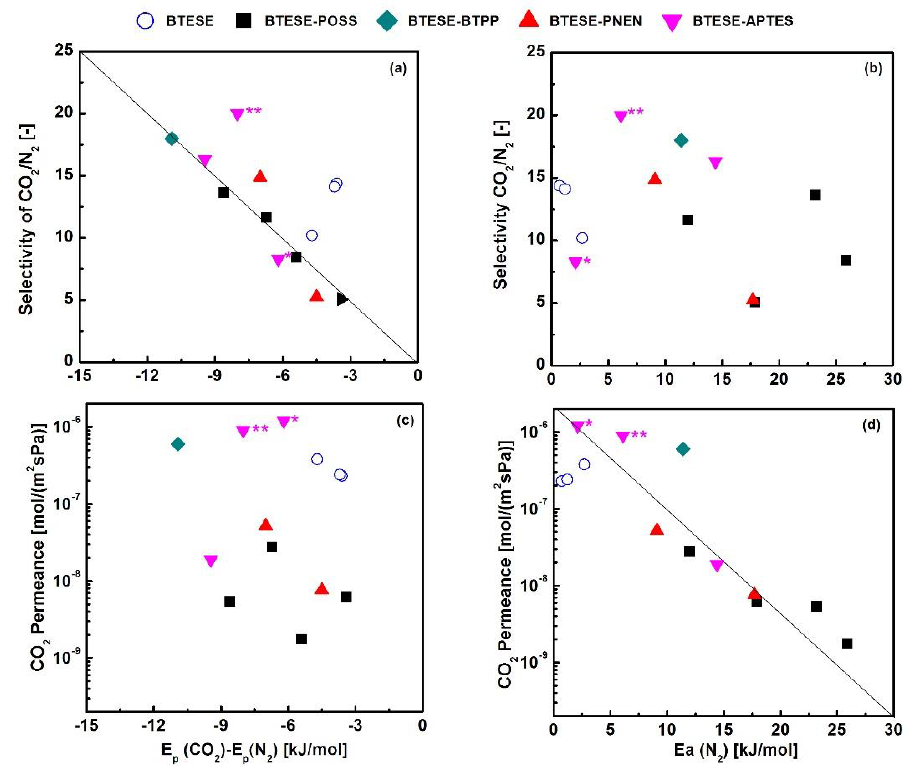
Figure 9. ( a ) Selectivity of CO 2 /N 2 vs E p (CO 2 )-E p (N 2 ) ( b ) selectivity of CO 2 /N 2 vs E p (N 2 ) ( c ) permeance of CO 2 vs E p (CO 2 )-E p (N 2 ) ( d ) permeance of CO 2 vs E p (N 2 ) for BTESE and related amine-hybrid organosilica membranes at 30–50 ◦ C. (BTESE [40], BTESE-BTPP (50%) [38], BTESE-POSS (10–66.7%) [23], BTESE-PNEN (2, 20%) BTESE-APTES [this work], * BTESE-APTES (25%), ** BTESA-APTES (10%) [11,17]), BTPP: 4,6-bis(3-(triethoxysilyl)-1-propoxy)-1,3-pyrimidine; APTES: 3-aminopropyl triethoxysilane; POSS: